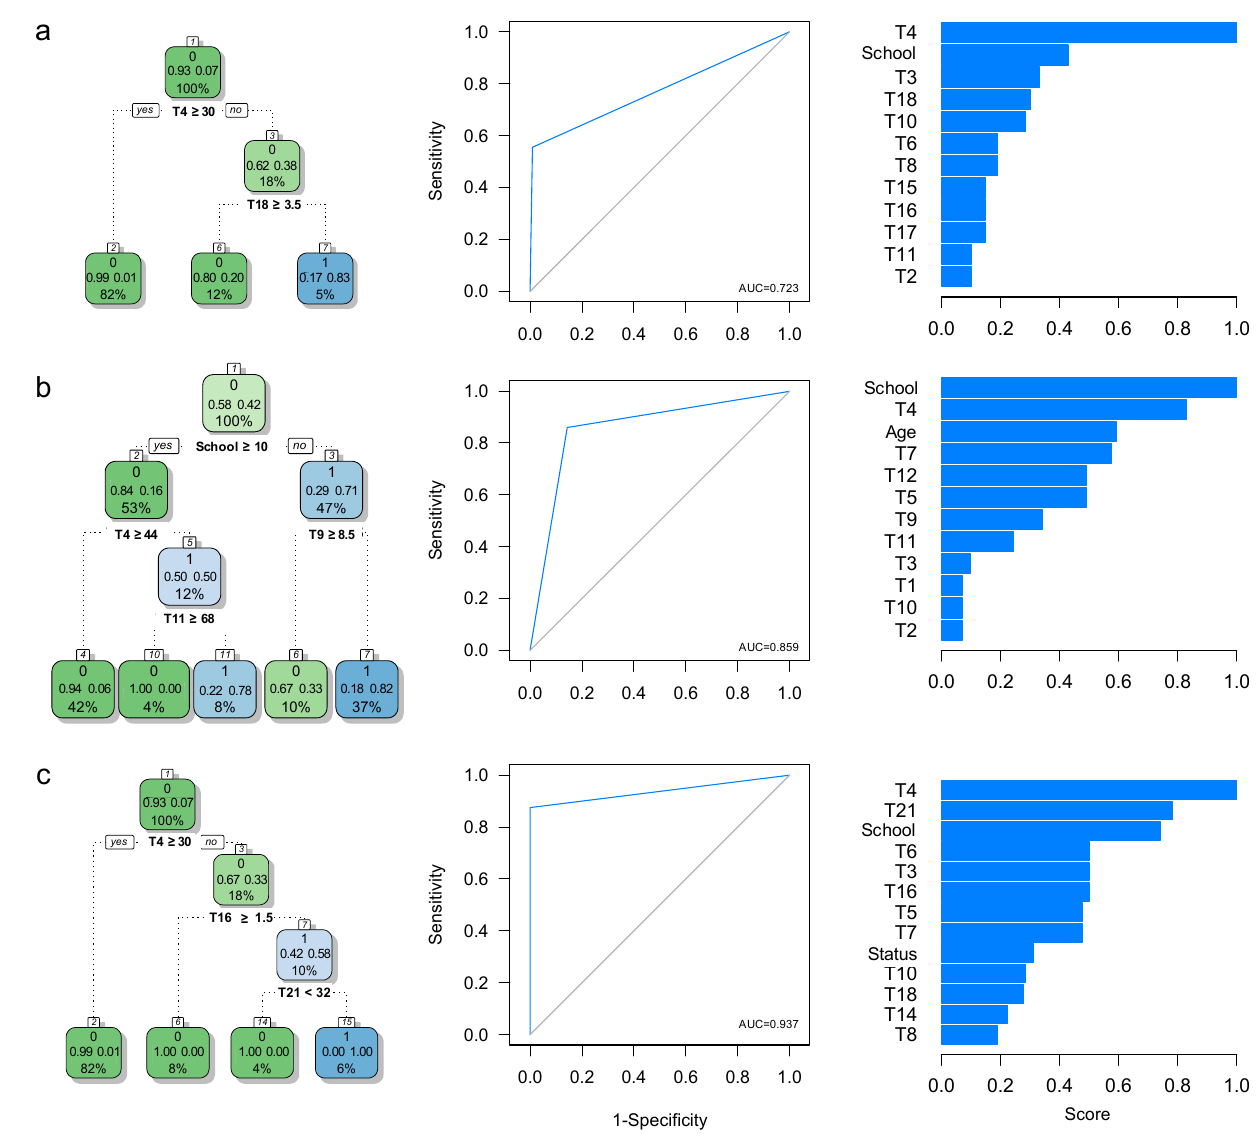
Figure 2. Results of the ARPA-based predictive model for HAND screening in individuals with HIV-1 Infection from the Colombian Caribbean. The HAND status was defined using ( a ) MMSE < 26, ( b ) IHDS ≤ 10, and ( c ) both MMSE < 26 and IHDS ≤ 10 (see Methods). ( left ) The classification tree derived using the CART strategy. Status: HIV-1 Infection status (0: control; 1: case). Other conventions as in Figure 1.